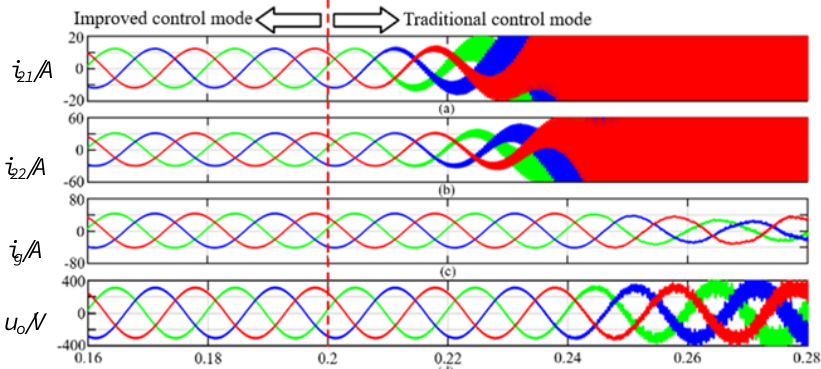
Figure 13. Simulation results of parallel inverters with different capacities switching from improved control mode to traditional control mode: ( a ) current waveform of inverter 1; ( b ) current waveform of inverter 2; ( c ) total current waveform; and ( d ) voltage waveform of PCC.